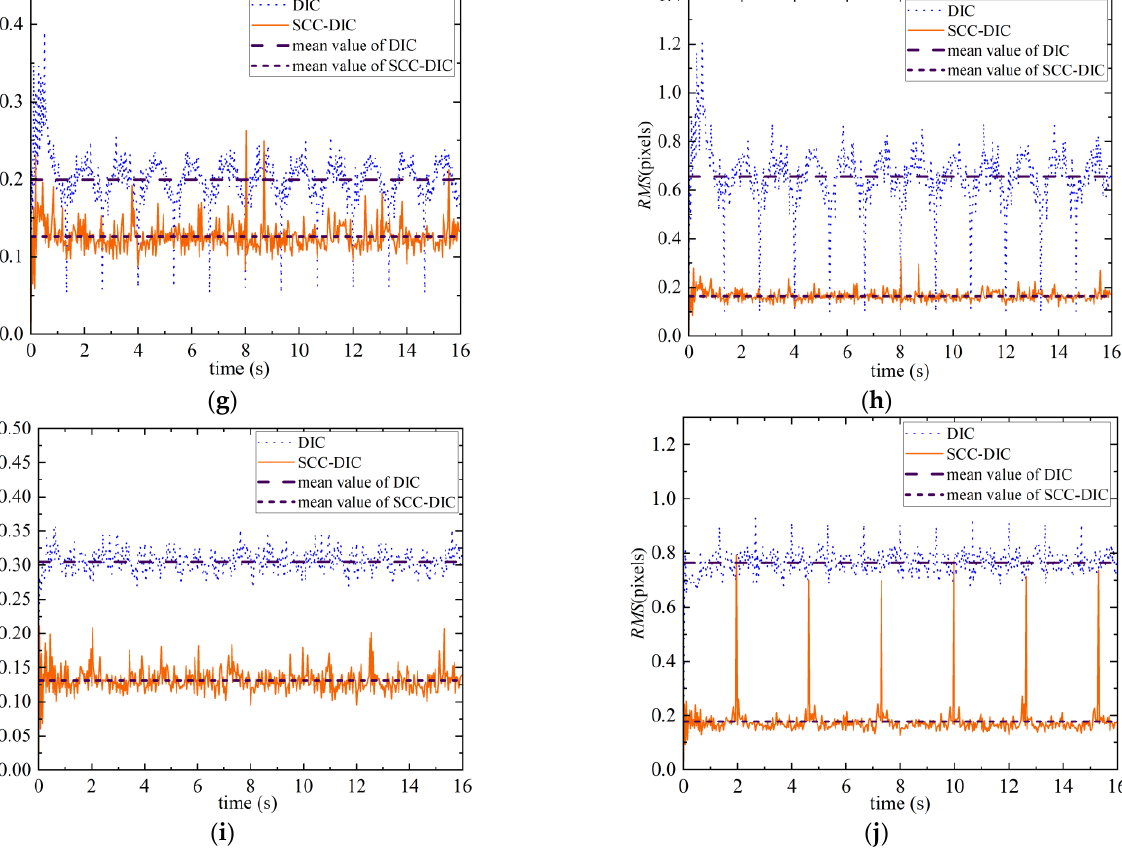
Figure 10. MAE and RMS of the two methods in all cases: ( a ) MAE of the two methods in case 1; ( b ) RMS of the two methods in case 1; ( c ) MAE of the two methods in case 2; ( d ) RMS of the two methods in case 2; ( e ) MAE of the two methods in case 3; ( f ) RMS of the two methods in case 3; ( g ) MAE of the two methods in case 4; ( h ) RMS of the two methods in case 4; ( i ) MAE of the two methods in case 5 ; ( j ) RMS of the two methods in case 5.